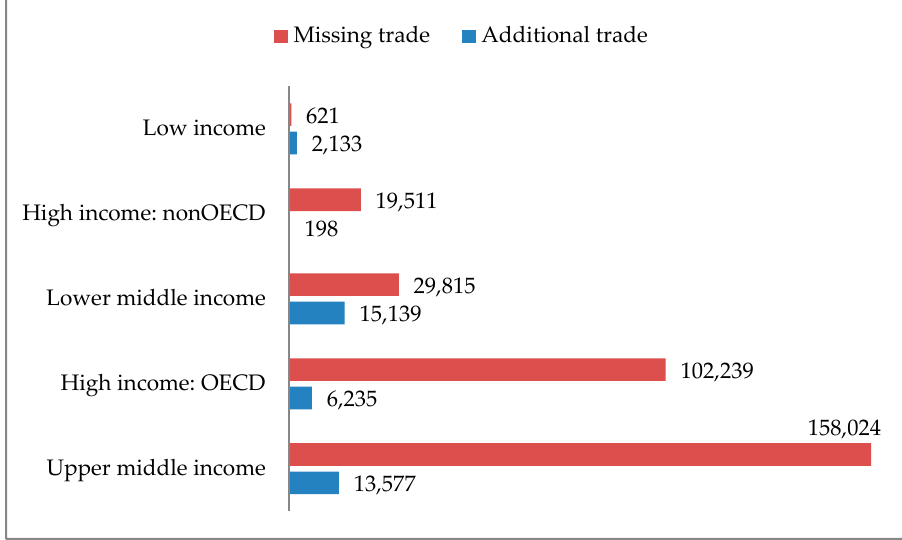
Figure 7. Trade effect due to protection: Results by countries according to income levels (CES Figure 7. Trade e ff ect due to protection: Results by countries according to income levels (CES reference reference tariff). At world prices; millions of €. Source: Elaboration on data by COMEXT and TRAINS; tari ff ). At world prices; millions of € . Source: Elaboration on data by COMEXT and TRAINS; 2017.